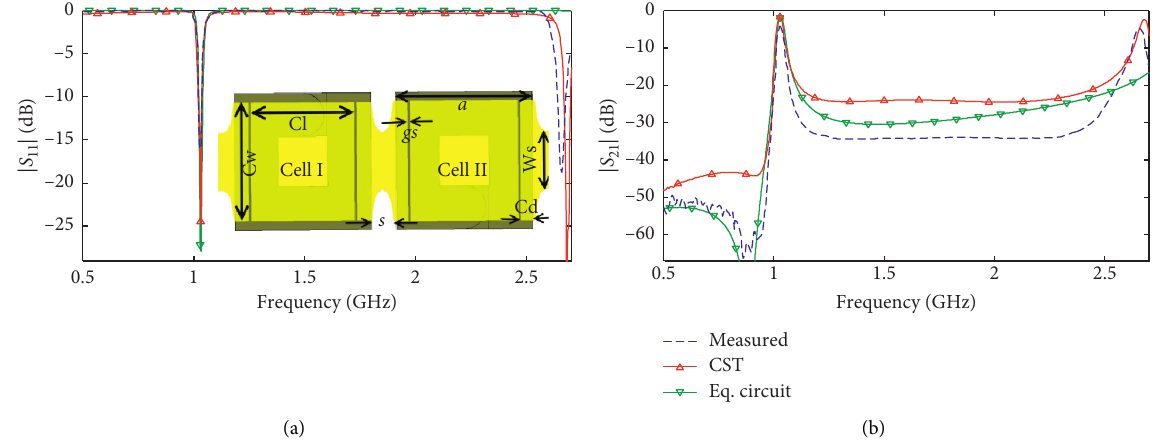
Figure 6: (a) | S | and (b) | S | of two cascaded DNG cells (where a � 12.9mm, w � 4.3mm, Ws � 5.5mm, Cl � 10mm, Cw � 11.4mm, 11 21 Cd � 1.4 mm, gs � 0.2mm, and s � (can be seen in Figures 7(b) and 7(c)) and were connected to filter. As shown in Figure 7(a), the transmission line with each other using copper ribbons to form quasiplanar res- gaps was printed on the top surface of the top layer. Two onators. The bottom layer was the ground plane. Finally, metal rings were printed on each sides of the middle layer